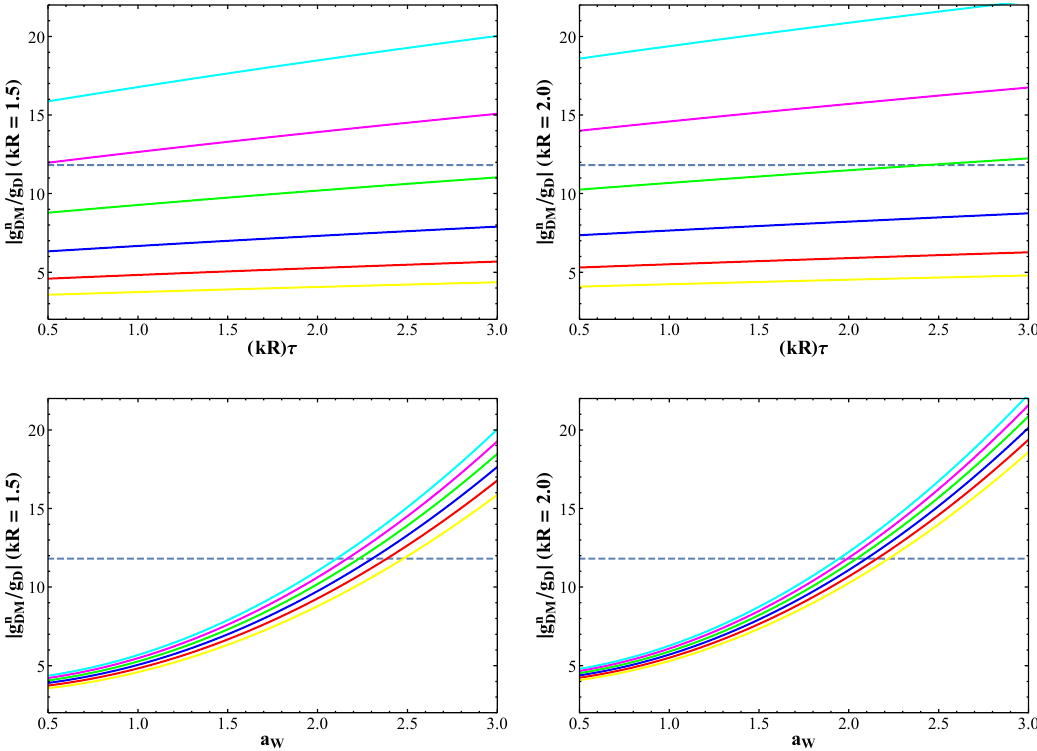
/g D | given by eq. (4.7) for large DM